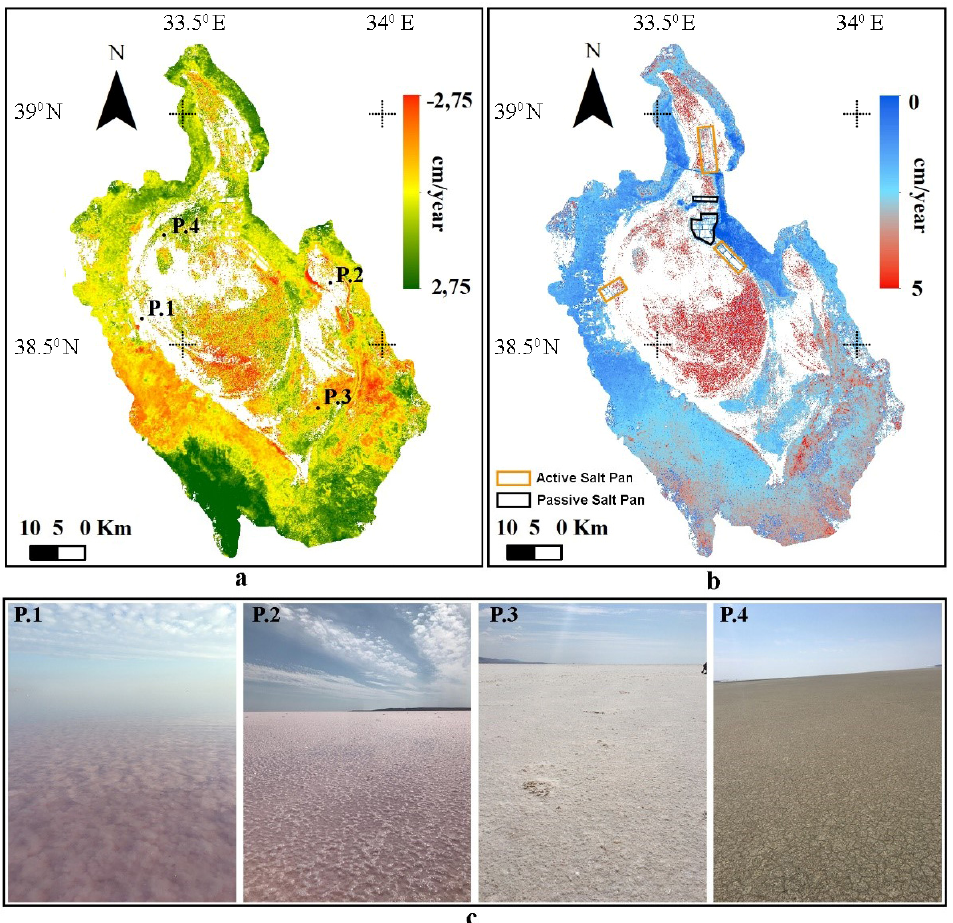
Figure 6. SBAS LOS direction velocity map for the 2017–2018 period. The final map is presented by cutting Lake Tuz and its surroundings (approximately 1900 km 2 ). Positive velocities (in green) represent the motion of the ground toward the satellite, while negative velocities (in red) represent motion away from the satellite ( a ). The spatial distribution of the standard deviation of the SBAS measurements ( b ). Photographs taken around Lake Tuz which have different structures ( c ).